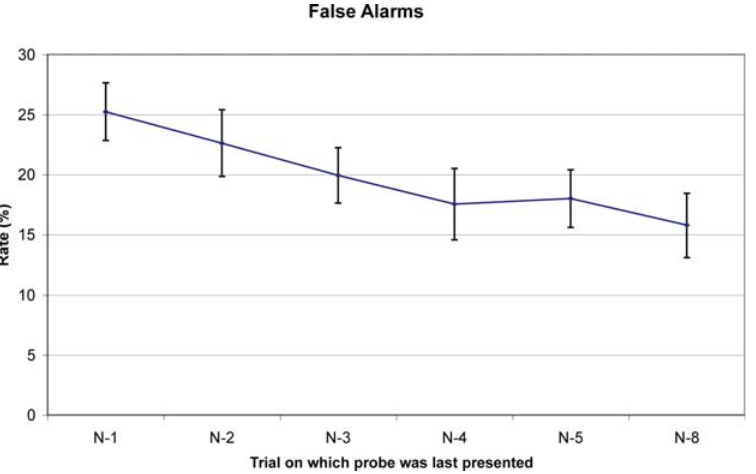
Figure 3. Experiment 1: False alarm rates (with standard errors) across as a function of probe’s last presentation.